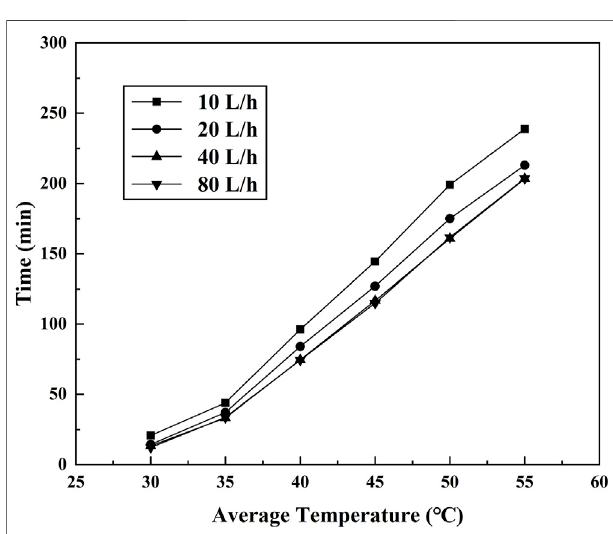
FIGURE 6 | Timewise variations of total heat storage during the melting process.